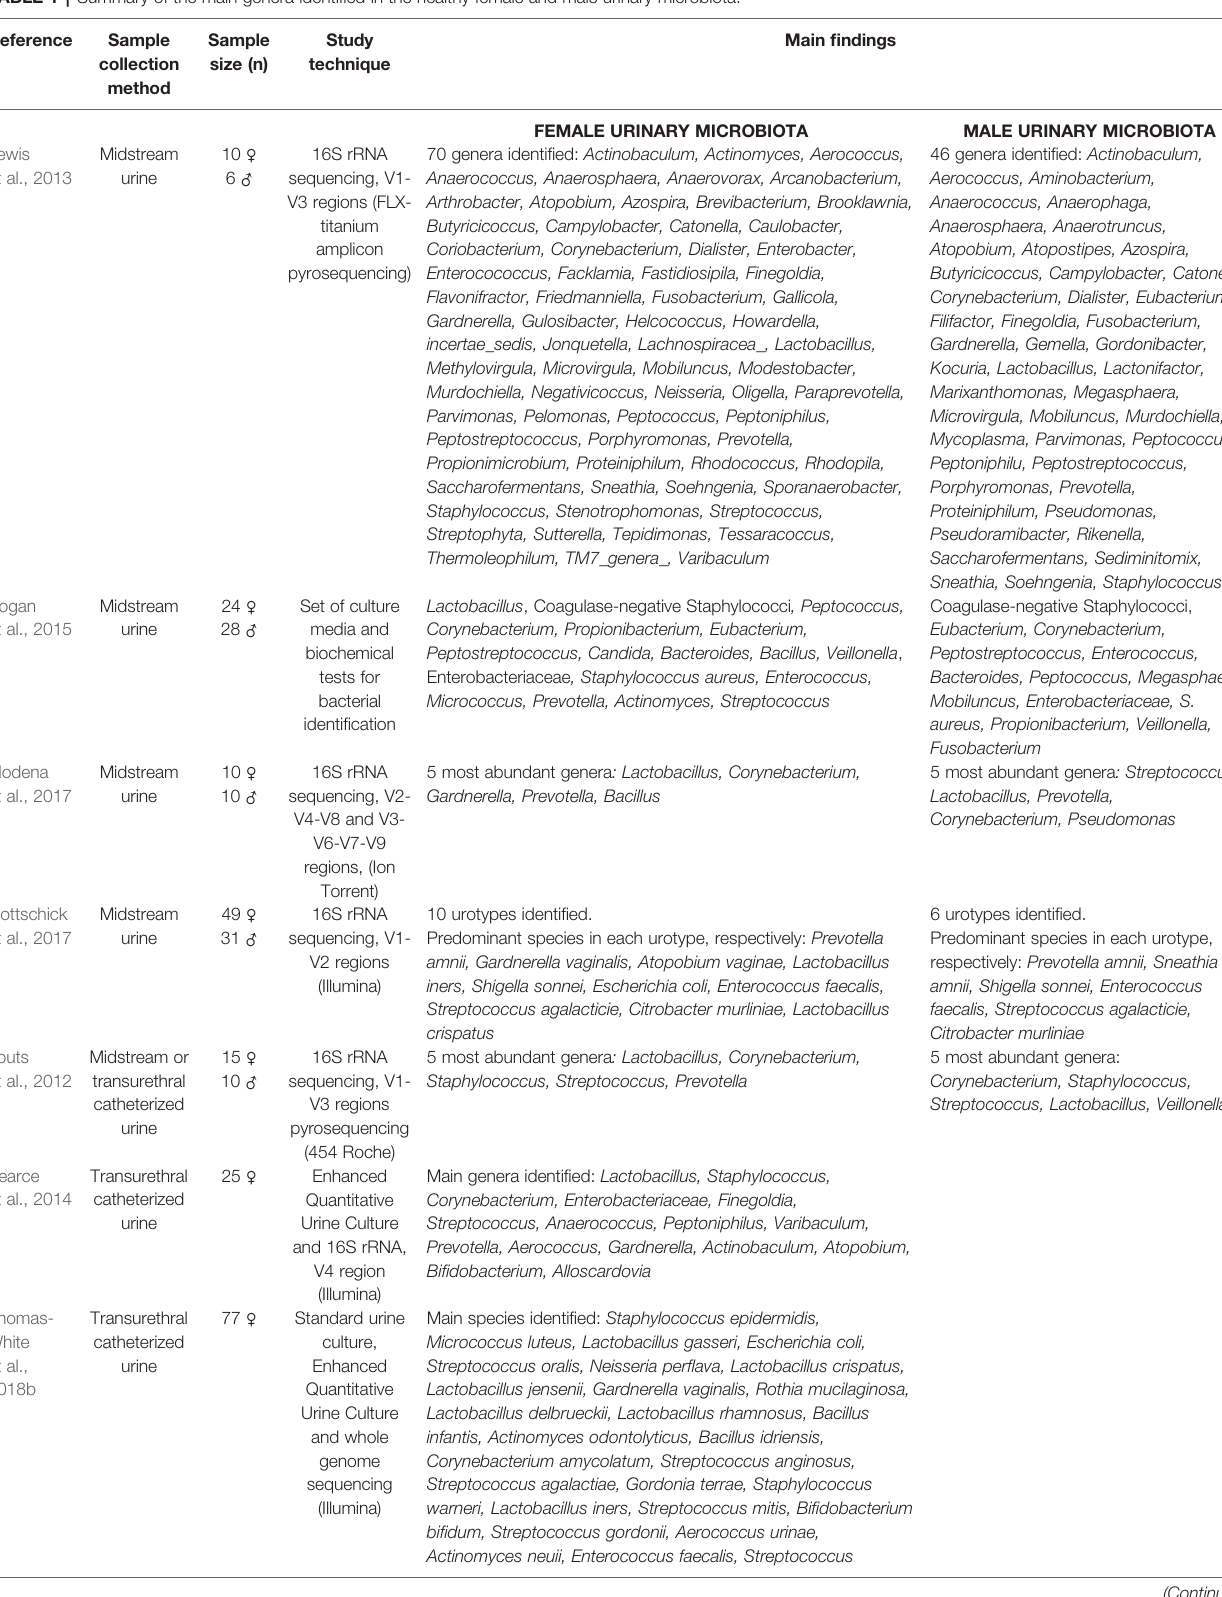
TABLE 1 | Summary of the main genera identi fi ed in the healthy female and male urinary